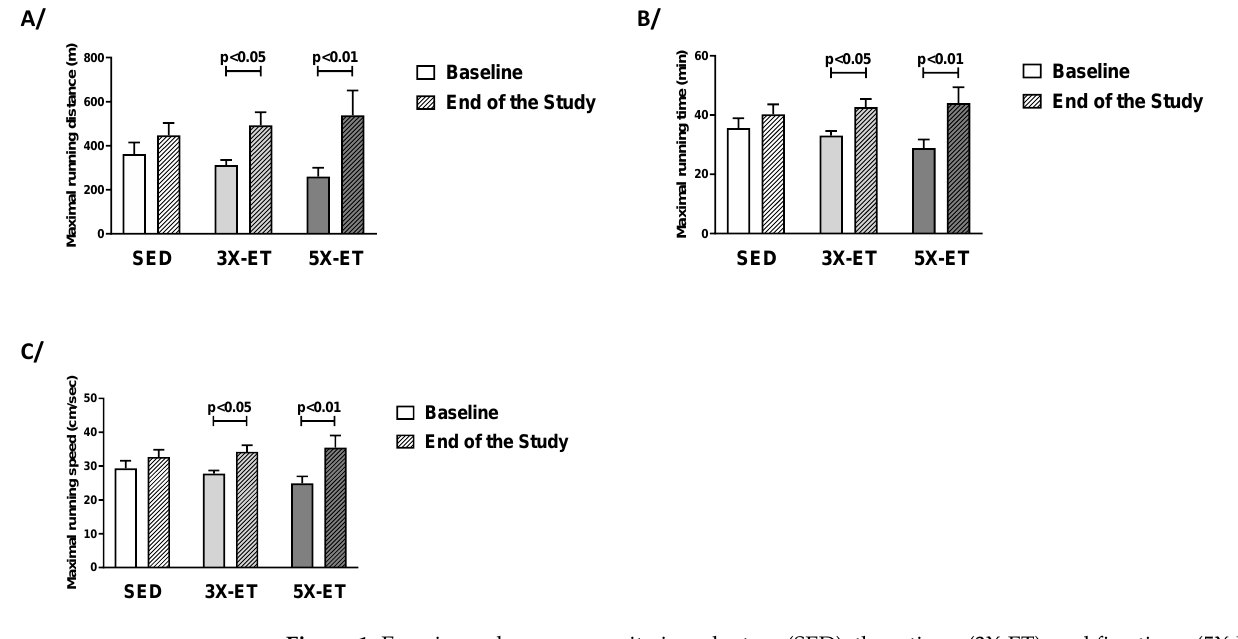
Figure 1. Exercise endurance capacity in sedentary (SED), three times (3X-ET), and five times (5X-ET) a week exercised ApoE −/− mice with PAD. Maximal running distance ( A ), maximal running time ( B ), and maximal running speed ( C ) were determined by an incremental treadmill running test to exhaustion ( n = 6–8 mice per group). Results presented as the mean ± SEM. Data were analyzed using two-way repeated measures ANOVA with Holm–Sidak’s post hoc